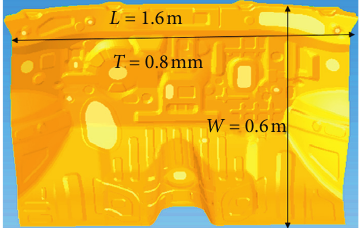
Figure 2: Finite element model of dash